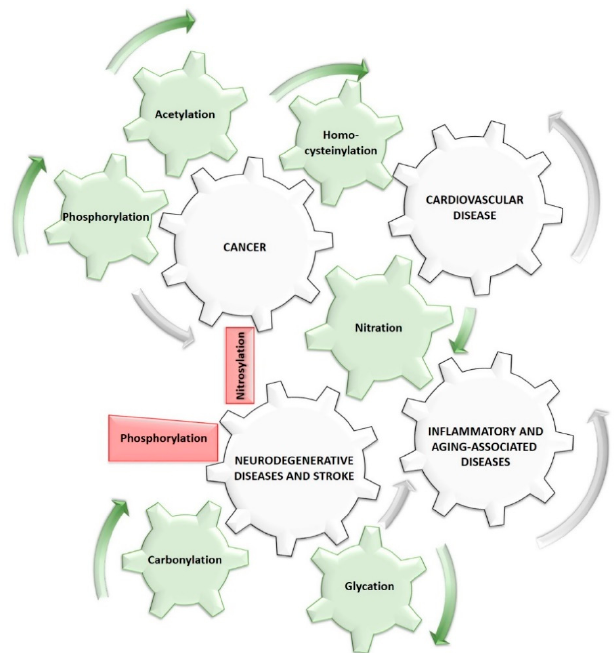
Figure 3. Cause–e ff ect of post-translational modifications of cytochrome c in human pathologies. Carbonylation, glycation and nitration of specific residues of C c promote the development of several neurodegenerative diseases and strokes. However, phosphorylated C c at positions 47 and 97, or nitrosylated in its tyrosine residues has been revealed to be a neuroprotective agent against this type of pathology. Cancer cells show many modifications of heme protein, such as phosphorylations, acetylations, homocysteinilations, and nitrations. Nitrosylation and phosphorylation are mutually exclusive modifications, so the presence of nitrosylated C c species could be act as an anticancer